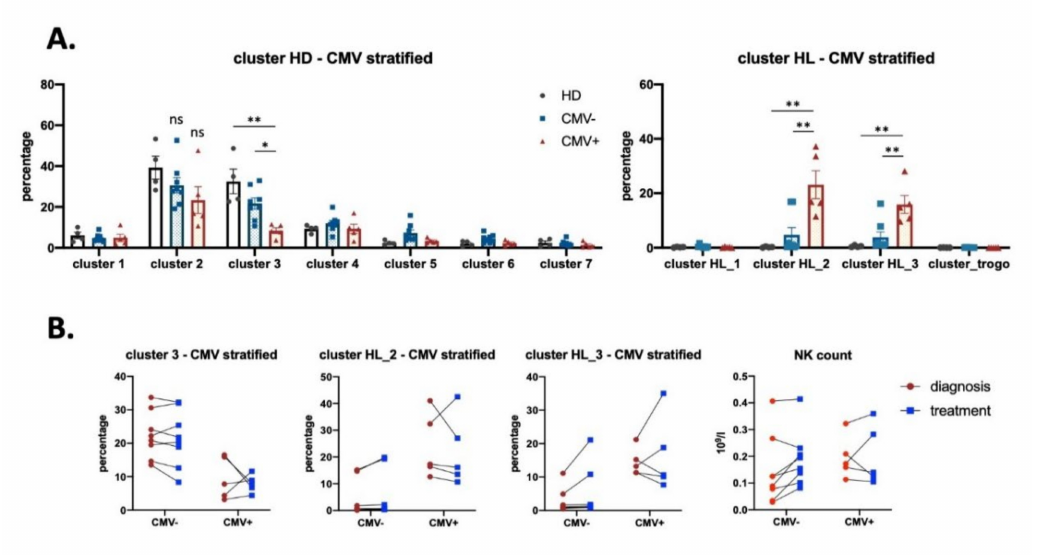
Figure 5. Analysis of NK cells from HL patients stratified by CMV serotypes. Graphs represent the percentage of NK cells in each cluster in HD, CMV − ( n = 8) and CMV + ( n = 5) patients (based on CMV serotype, although in the absence of CMV reactivation). ( A ) NK cluster quantification between HD and both CMV − /+ groups. ( B ) Change in NK cluster proportion before and after treatment in the 2 CMV groups. * p < 0.05, ** p <